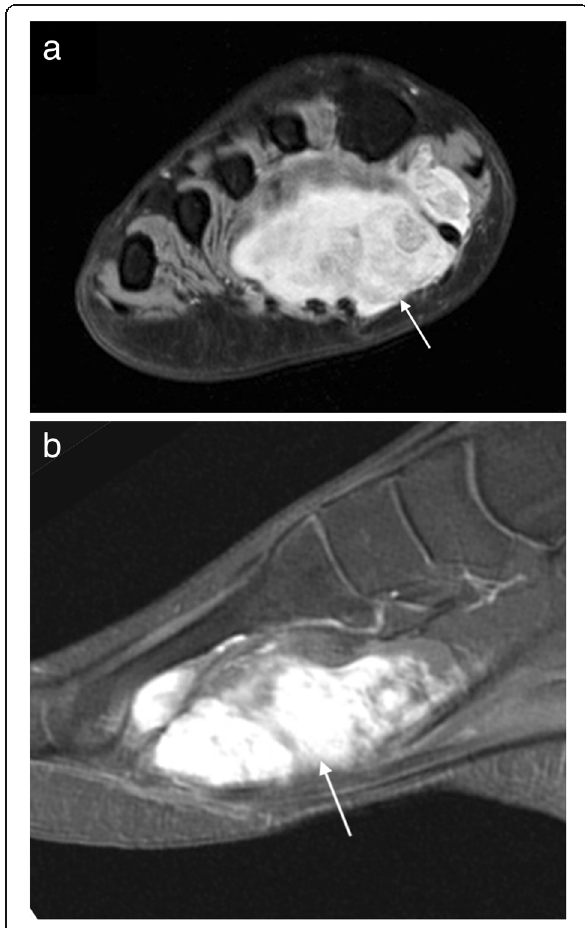
Fig. 11 Synovial sarcoma. Short axis T2FS image of the foot ( a ) showing a heterogeneous T2 hyperintense mass on the plantar aspect of the foot with heterogeneous enhancement of the viable tumour on the sagittal post-contrast T1FS image ( b )